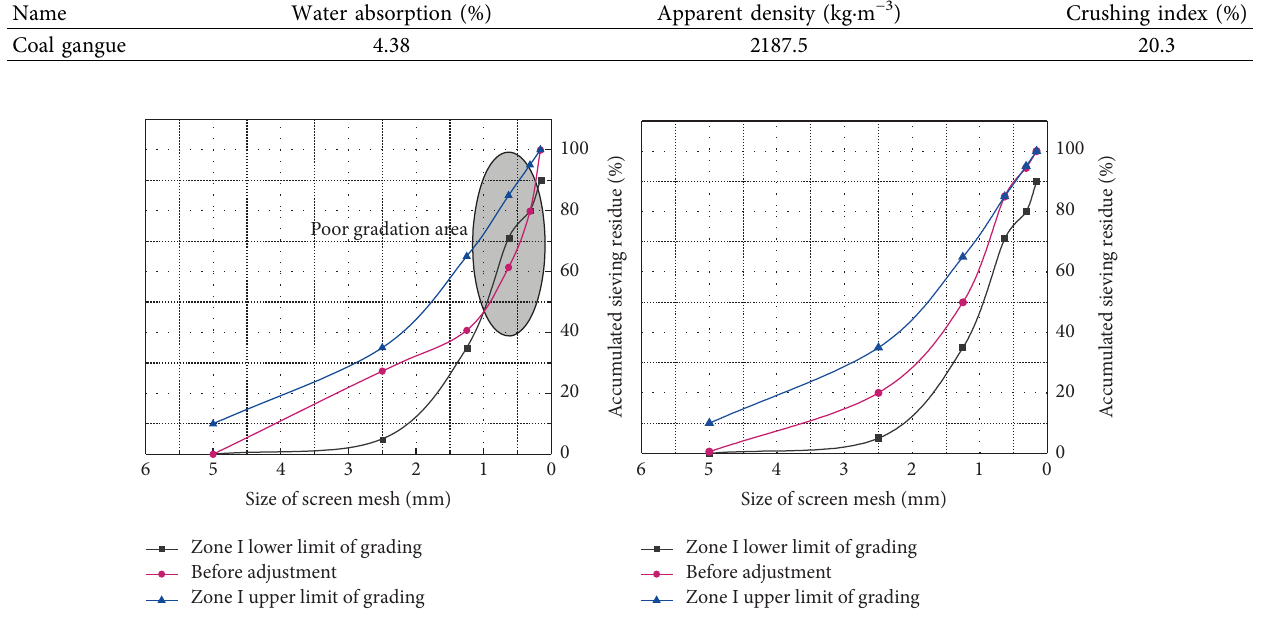
Figure 1: Grading curve of coal gangue sand. Table 2: Index of P · O42.5 cement.